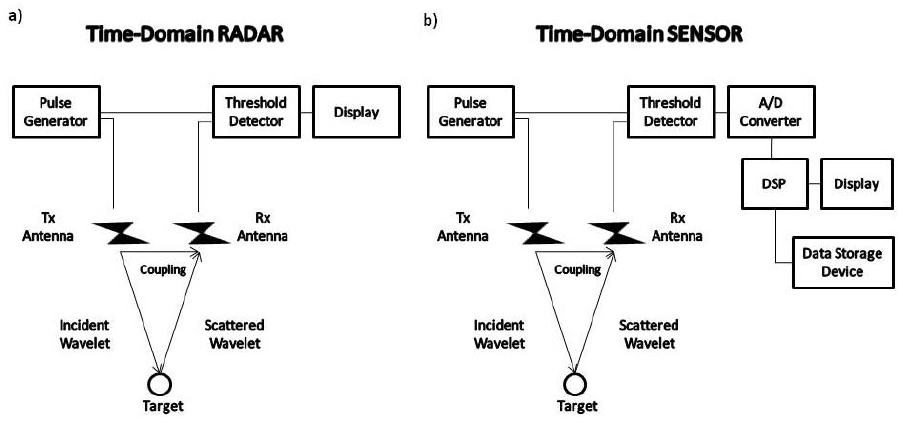
Figure 1. Classification of time domain radars according to the information obtained from the signal received. (a) Radar’s schematic layout. (b) Sensor’s schematic